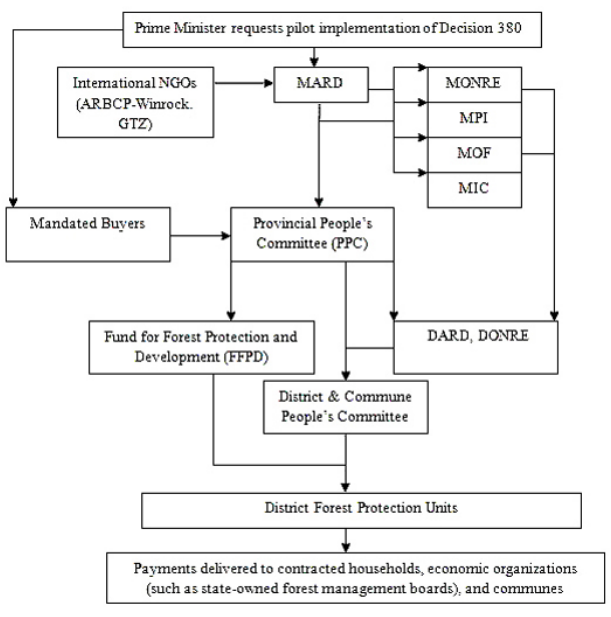
Fig. 2 . The institutional arrangement for implementing pilot schemes under Vietnam’s Decision 380 and subsequent payments for ecosystem services (PES) law. DARD = Department of Agriculture and Rural Development; DONRE = Department of Natural Resources and Environment; MONRE = Ministry of Natural Resources and Environment; MPI = Ministry of Planning and Investment; MOF = Ministry of Finance; MIC = Ministry of Information and Communications (Pham et al. 2008, Nguyen et al.